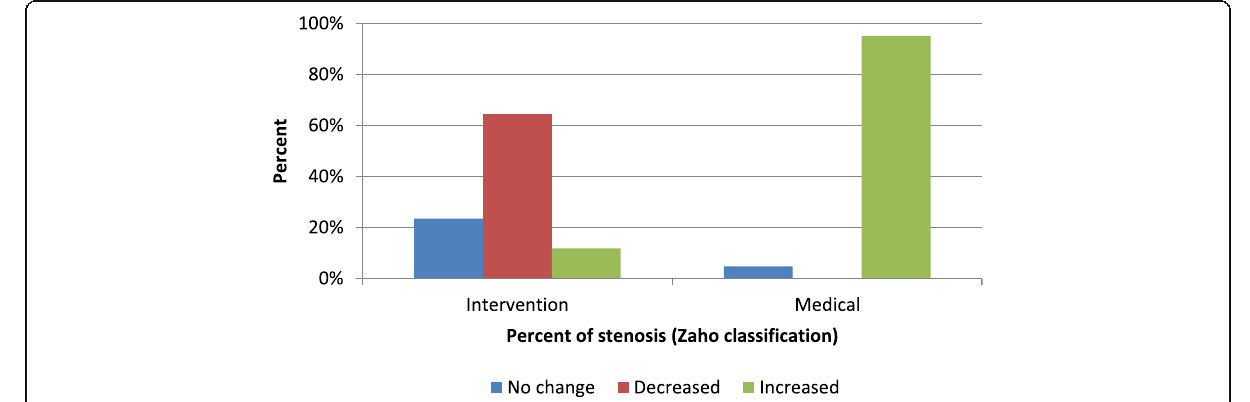
Fig. 4 Percent of stenosis in TCD among both groups pre-intervention and 3 months post intervention